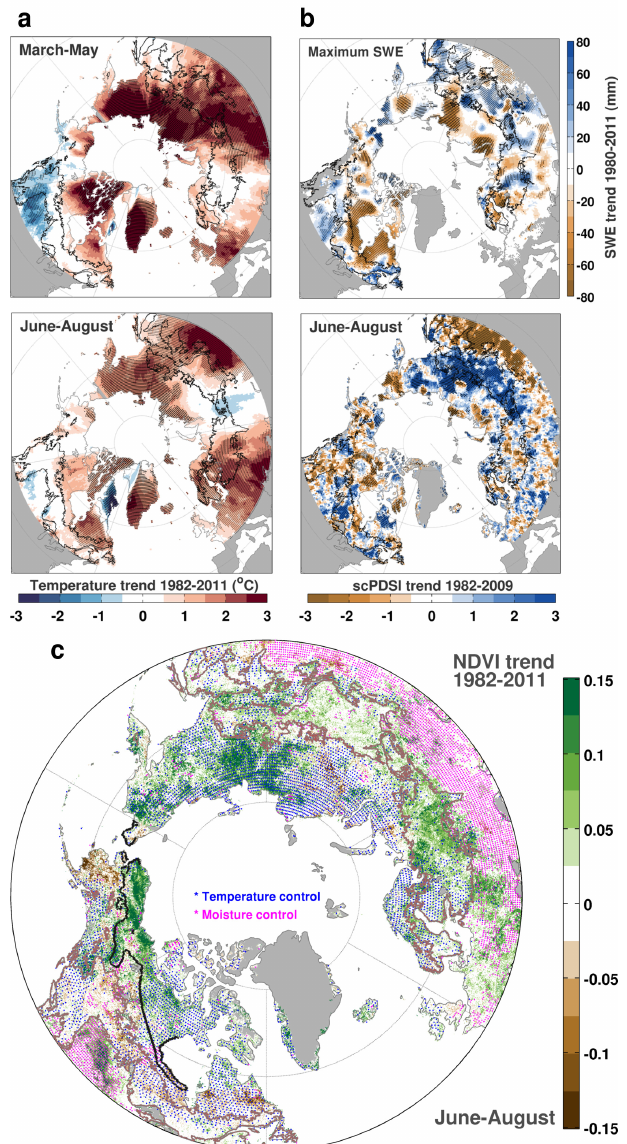
Linear trends in summer NDVI and dominant climate drivers since 1982. ( a ) Trends in spring and summer temperature between 1982 and 2011; ( b ) Trends in maximum SWE and summer scPDSI over the periods 1982–2011 and 1982–2009, respectively; ( c ) Statistically significant ( p < 0.1) trends in summer NDVI between 1982 and 2011. The colored stippling indicates regions where spring-summer moisture (purple) and temperature (blue) variability significantly influence interannual summer NDVI anomalies as shown in Figure 6b,c. The black thick line in North America denotes the southern edge of the continuous permafrost region